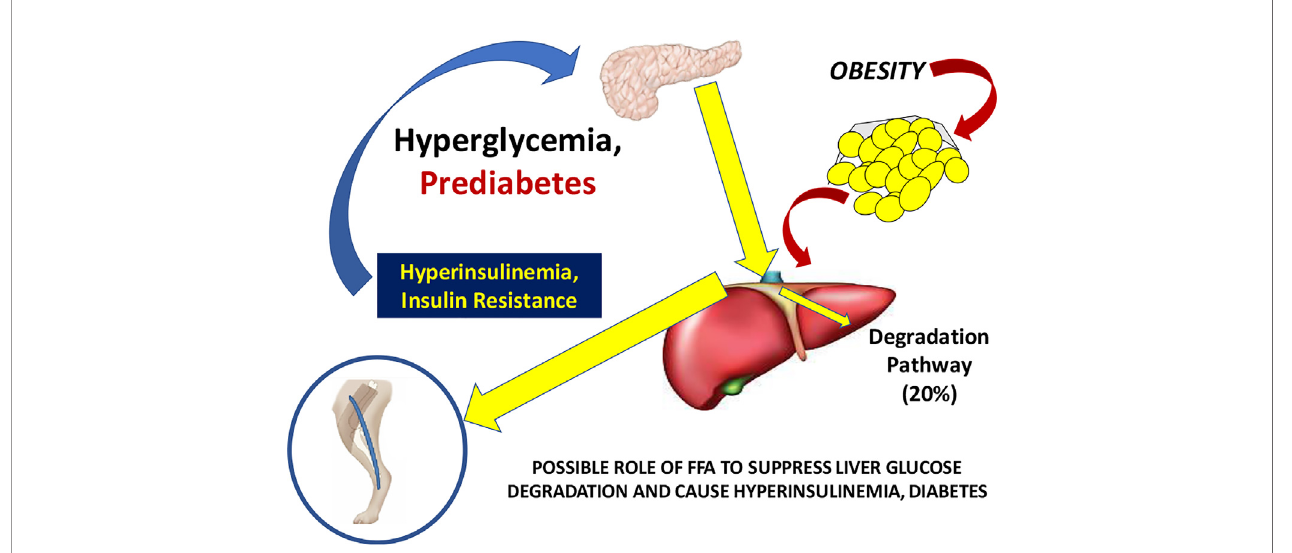
FIGURE 17 | Hypothesis of the pathogenesis of Type 2 diabetes. It is suggested that increased plasma free fatty acids cause a reduction in hepatic insulin clearance, possibly by downregulation of IDE. A large proportion of insulin secreted by the b -cells therefore bypasses fi rst-pass degradation, resulting in peripheral hyperinsulinemia. Higher plasma insulin downregulates skeletal muscle insulin sensitivity, stressing b -cells, and resulting in